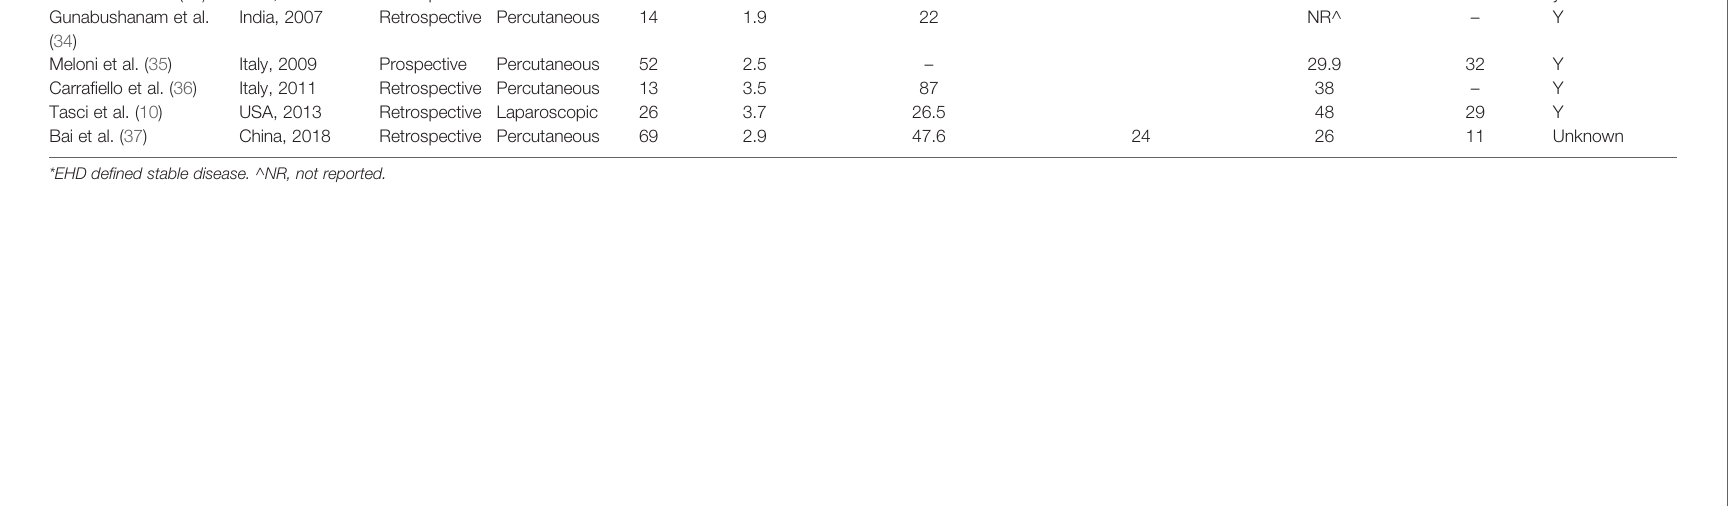
Coldwell et al. (39) Jakobs et al. (40) 2008,